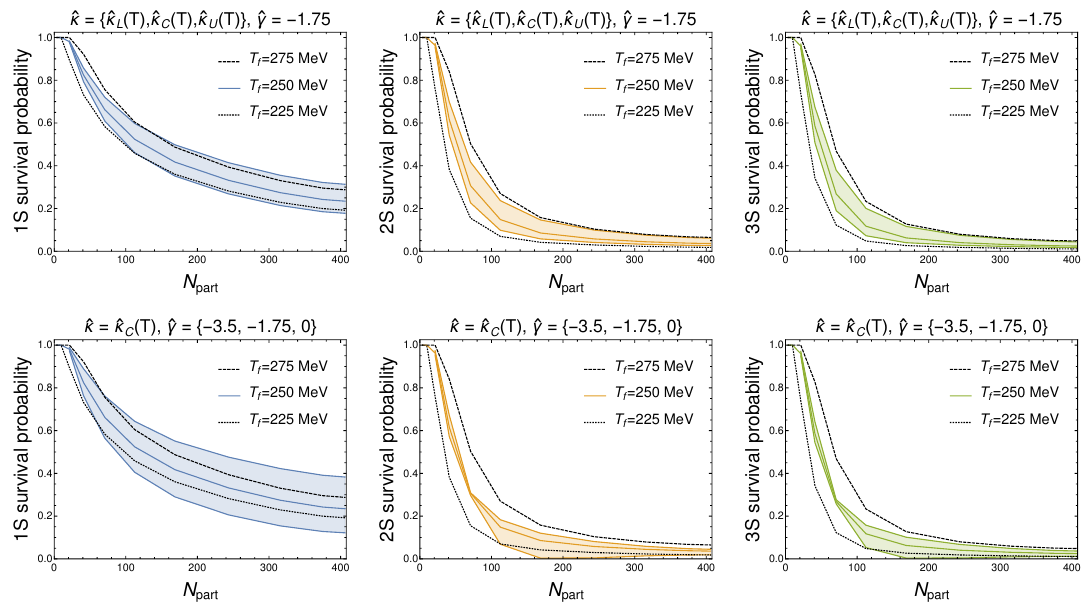
Figure 19 . 1 S , 2 S , and 3 S survival probabilities of an initial Gaussian state evolved with H eff , i.e., without jumps. The central colored line in each panel represents the evolution down to T f = 250 MeV with ˆ κ C ( T ) and ˆ γ = − 1 . 75 . The colored bands represent variations in ˆ κ (upper row) and ˆ γ (lower row). The black dashed and dotted lines represent the evolution down to T f = 275 MeV and 225 MeV, respectively, with ˆ κ C ( T ) and ˆ γ = − 1 . 75 .